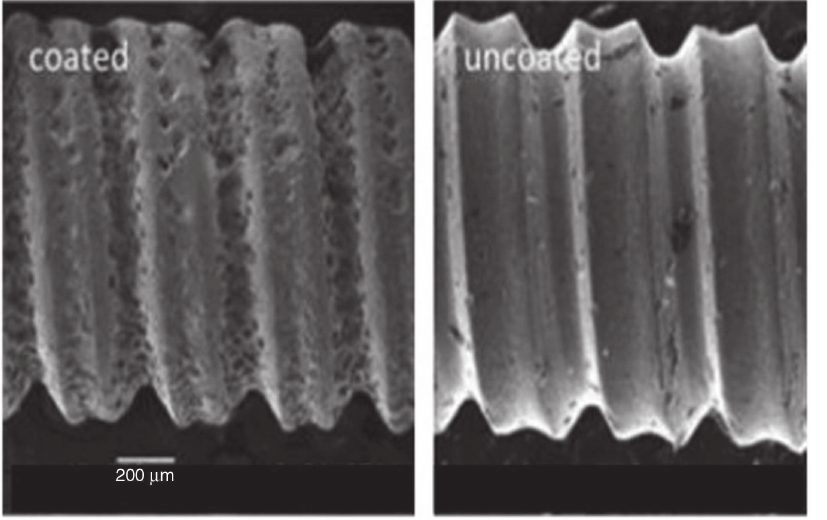
Figure 18: The bioactive glass coating on a Ti6Al4V (6% Aluminium, 4% Vanadium, 0.25% (maximum) Iron, 0.2% (maximum) Oxygen and the remainder Titanium) implant screw. Image available at Ref.